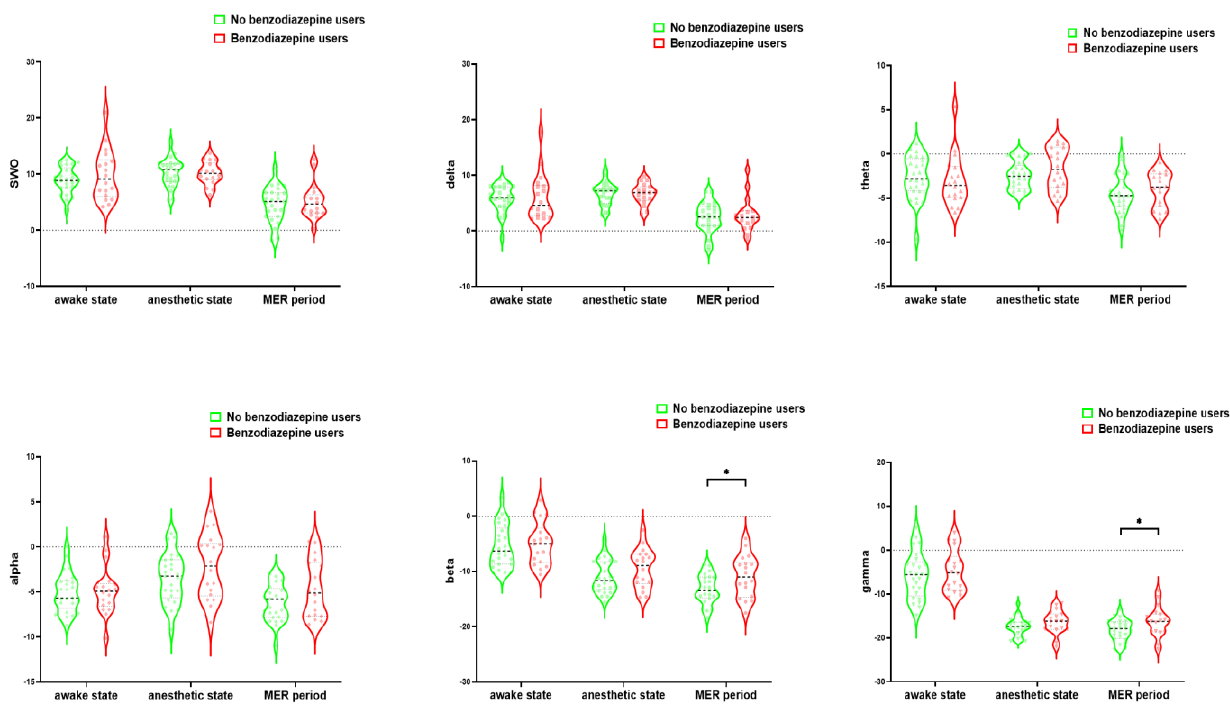
Figure 4. Power spectral density data of one patient in three states.